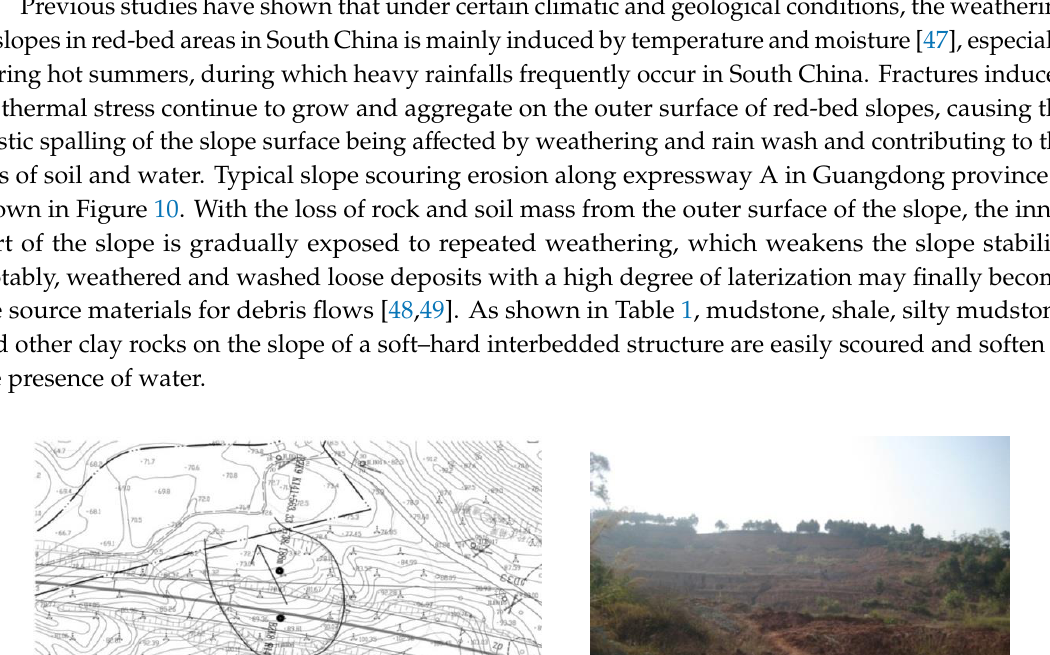
Figure 10. Slope scouring erosion of a slope in the expressway A, Guangdong, China.